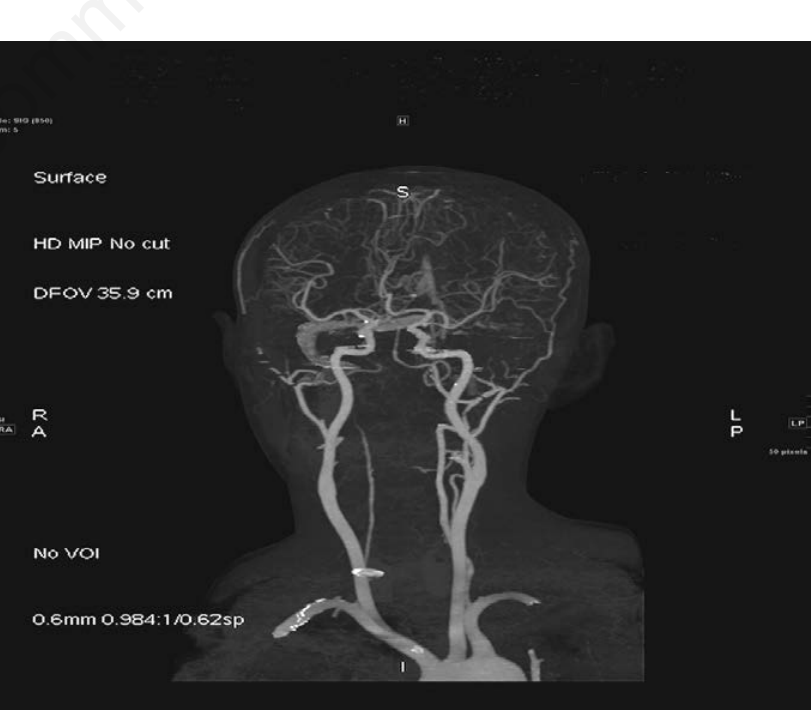
Figure 1. Tc-99m ethyl cysteinate dimer (ECD) brain perfusion single photon computed tomography fusion with CT imaging (SPECT/CT) showed asymmetry hypoperfusion (white arrow) at right cerebellum. In comparison, homogeneous red colon in the left cerebellum means normal findings of cerebellum perfusion. Brain perfusion SPECT/CT was performed 30 minutes after intravenous injection of 740 MBq Tc-99m ECD in a room with low level of ambient light and minimal background noise. Brain perfusion SPECT detects regional cerebral blood flow and has been widely used to evaluate various neurological disorders (white arrow head).